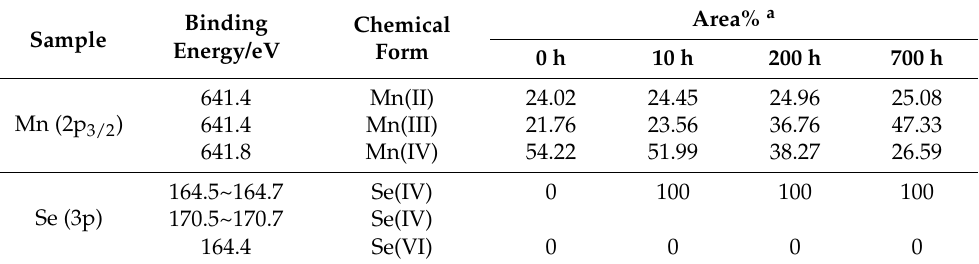
Figure 4. δ -MnO 2 reacted with fitted Mn2p3/2 spectrum of δ -MnO 2 after reaction with 100 µ M of Se(IV) at a pH of 4 and 25 °C for 0 h, 10 h, 200 h, and 700 h. Table 3. Binding energy and proportions of Mn and Se in the δ -MnO 2 near-surface reacted with 100 μ M of Se(IV).